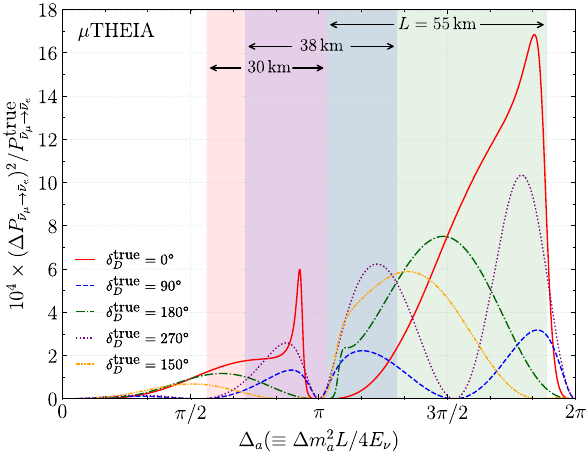
values. The neutrino energy D ) 2 / P true ¯ ν μ →¯ ν e e